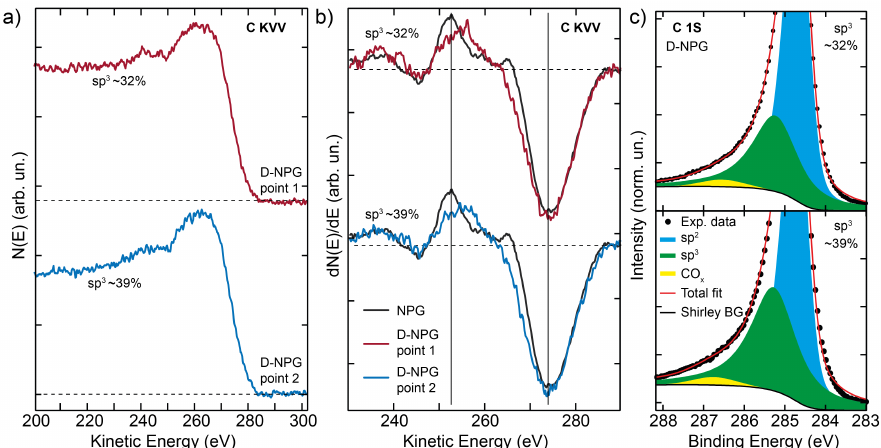
Figure 3. ( a ) Carbon KVV N(E) Auger electron spectroscopy peak taken on two different spatial points of the deuterated NPG (blue and red lines). ( b ) Numerically derived first derivative [dN(E)/dE] of the C KVV Auger signal from panel ( a ) compared with the derivative of the Auger signal for the pristine NPG (black lines). ( c ) C 1s core-level XPS spectra in a zoomed binding energy region and fitting curves, taken in the same spatial points of the deuterated NPG; experimental data (black dots), sp 2 fitting component (blue areas), sp 3 component (green areas), CO x component (yellow areas), Shirley background (black lines), and fitting sum curve (red